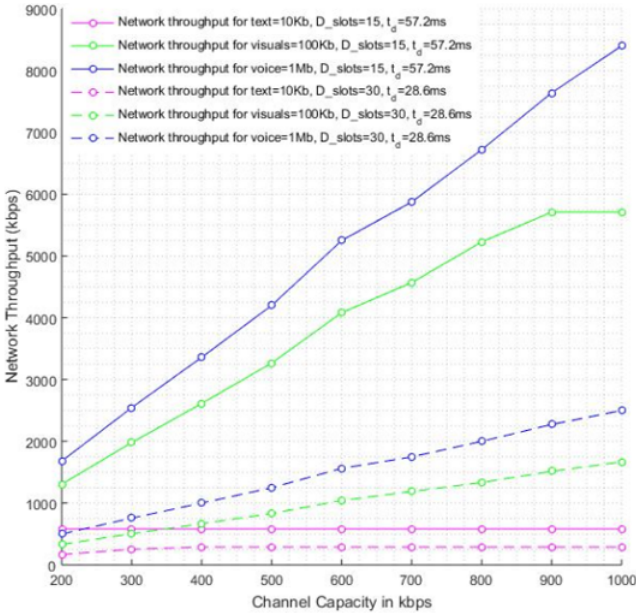
Figure 21. Network throughput with different number of sizes of data slots for N =